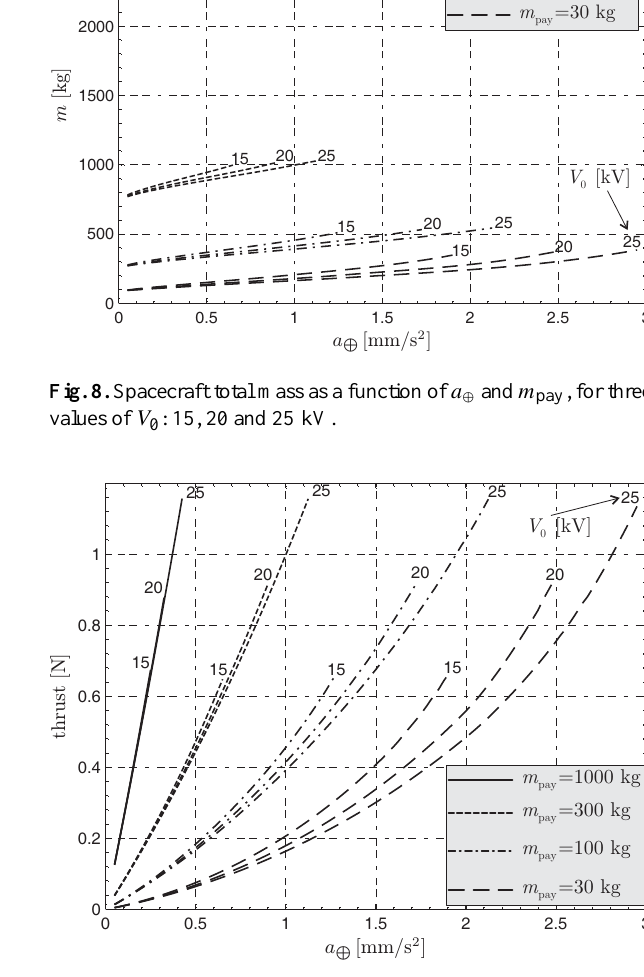
Fig. 9. E-sail thrust at 1AU as a function of a ⊕ and m pay , for three values of V 0 : 15, 20 and 25